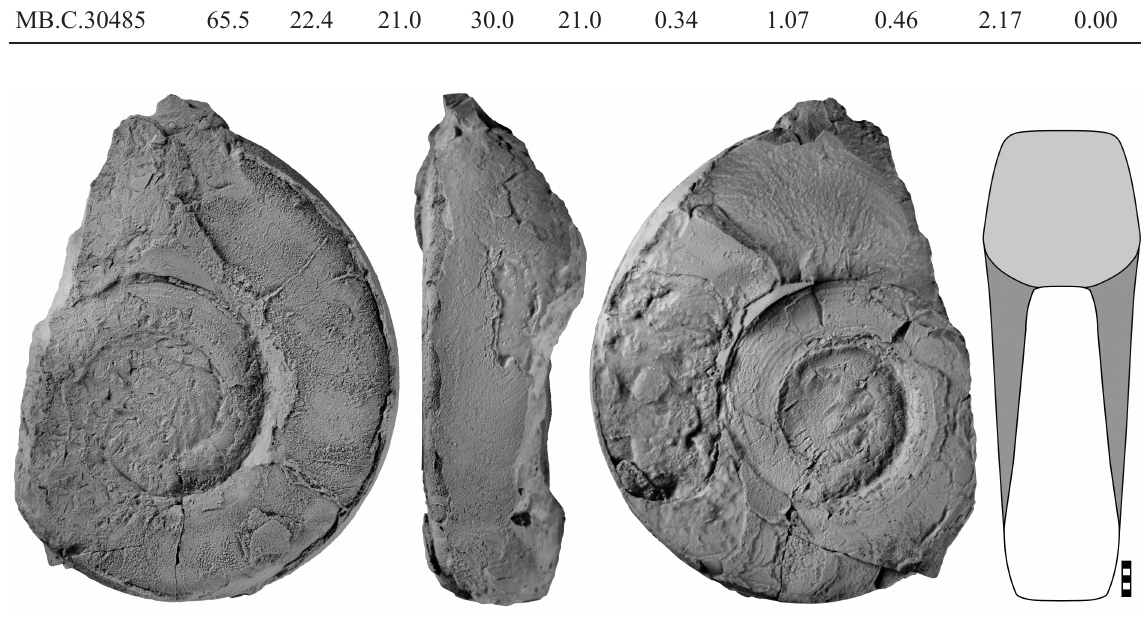
Table 16. Conch dimensions (in mm) and ratios of Maccoyoceras habadraense sp. nov.